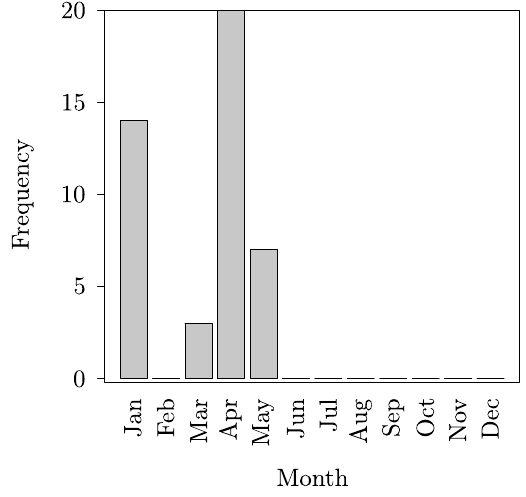
Figure 9: Monthly frequency of occurrence of exceedances.